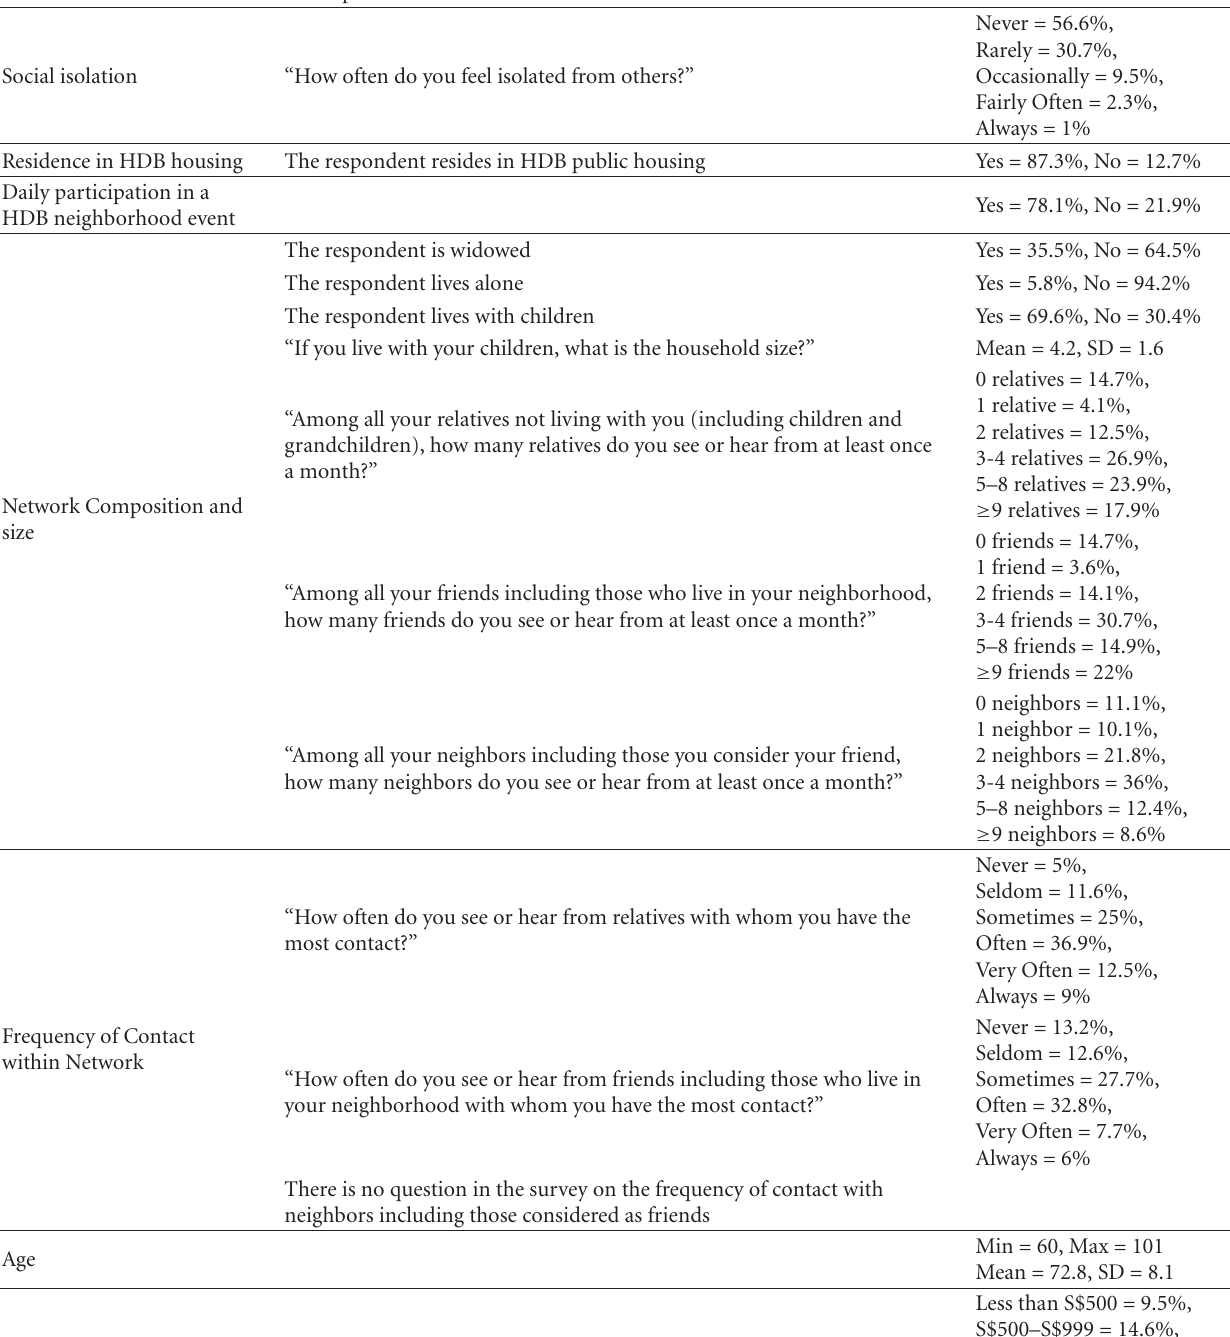
Table 1: Description of